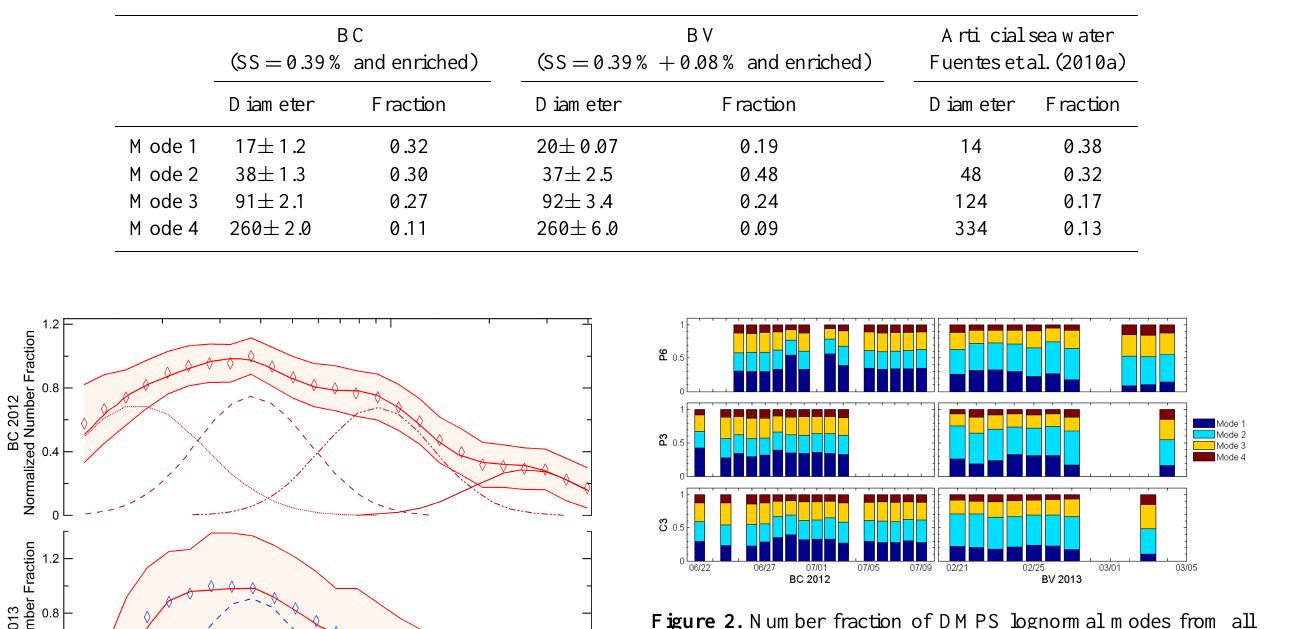
Table 2. Modal diameter (nm) and number fraction averages from the size distributions for both campaigns, including data from both supersaturations and microlayer enriched experiments. Lognormal modal diameters and number fractions from Fuentes et al. (2010a) are also shown.